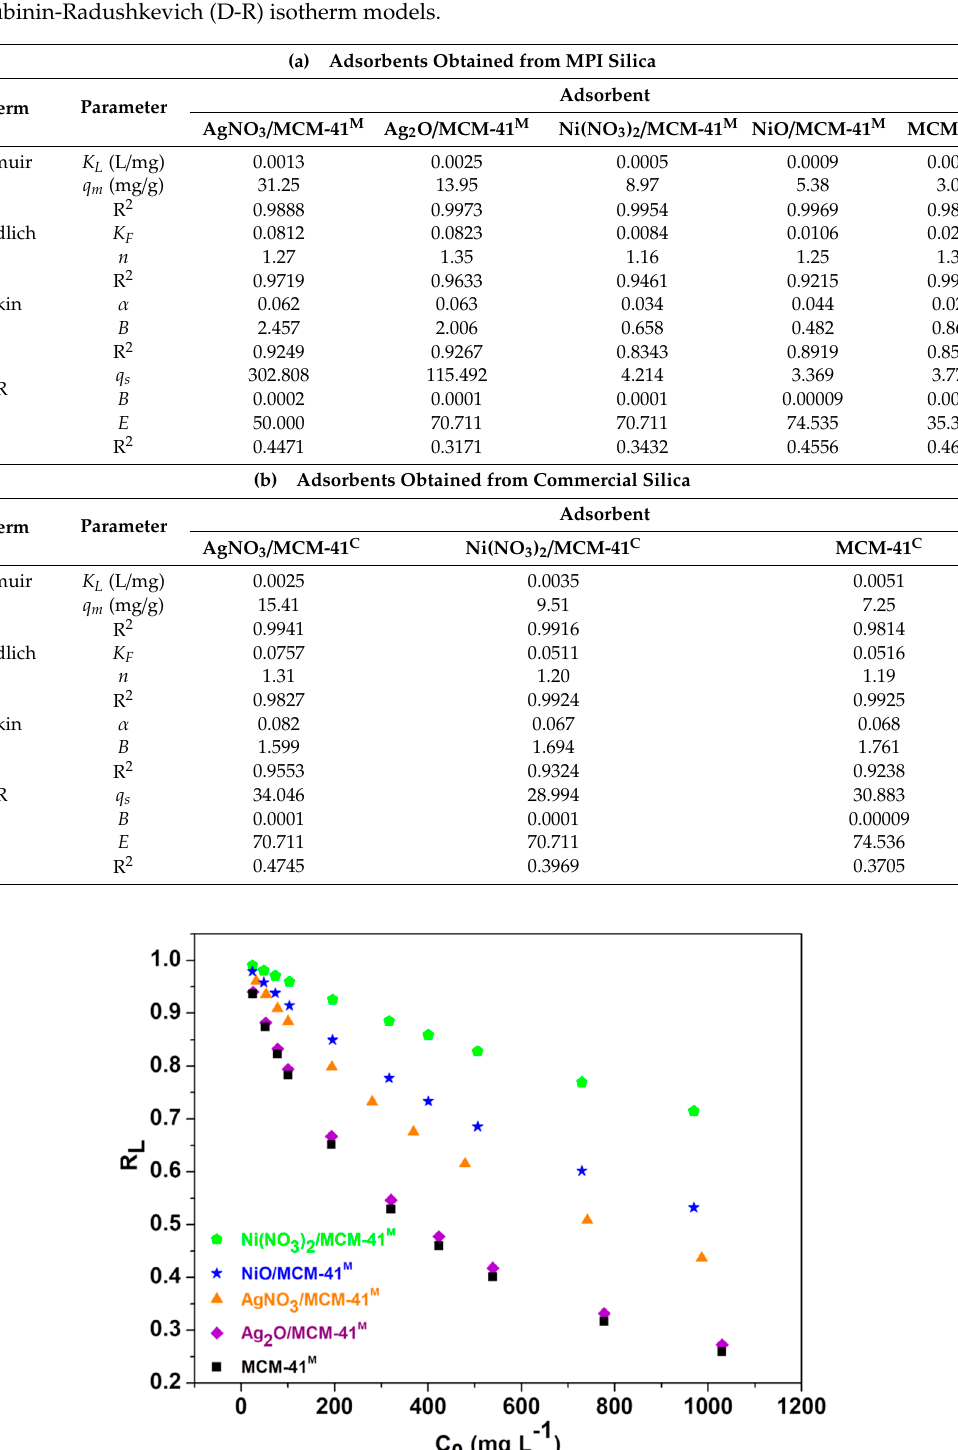
Table 4. Parameters and determination coefficients for Langmuir, Freundlich, Temkin and Dubinin- Radushkevich (D-R) isotherm models.